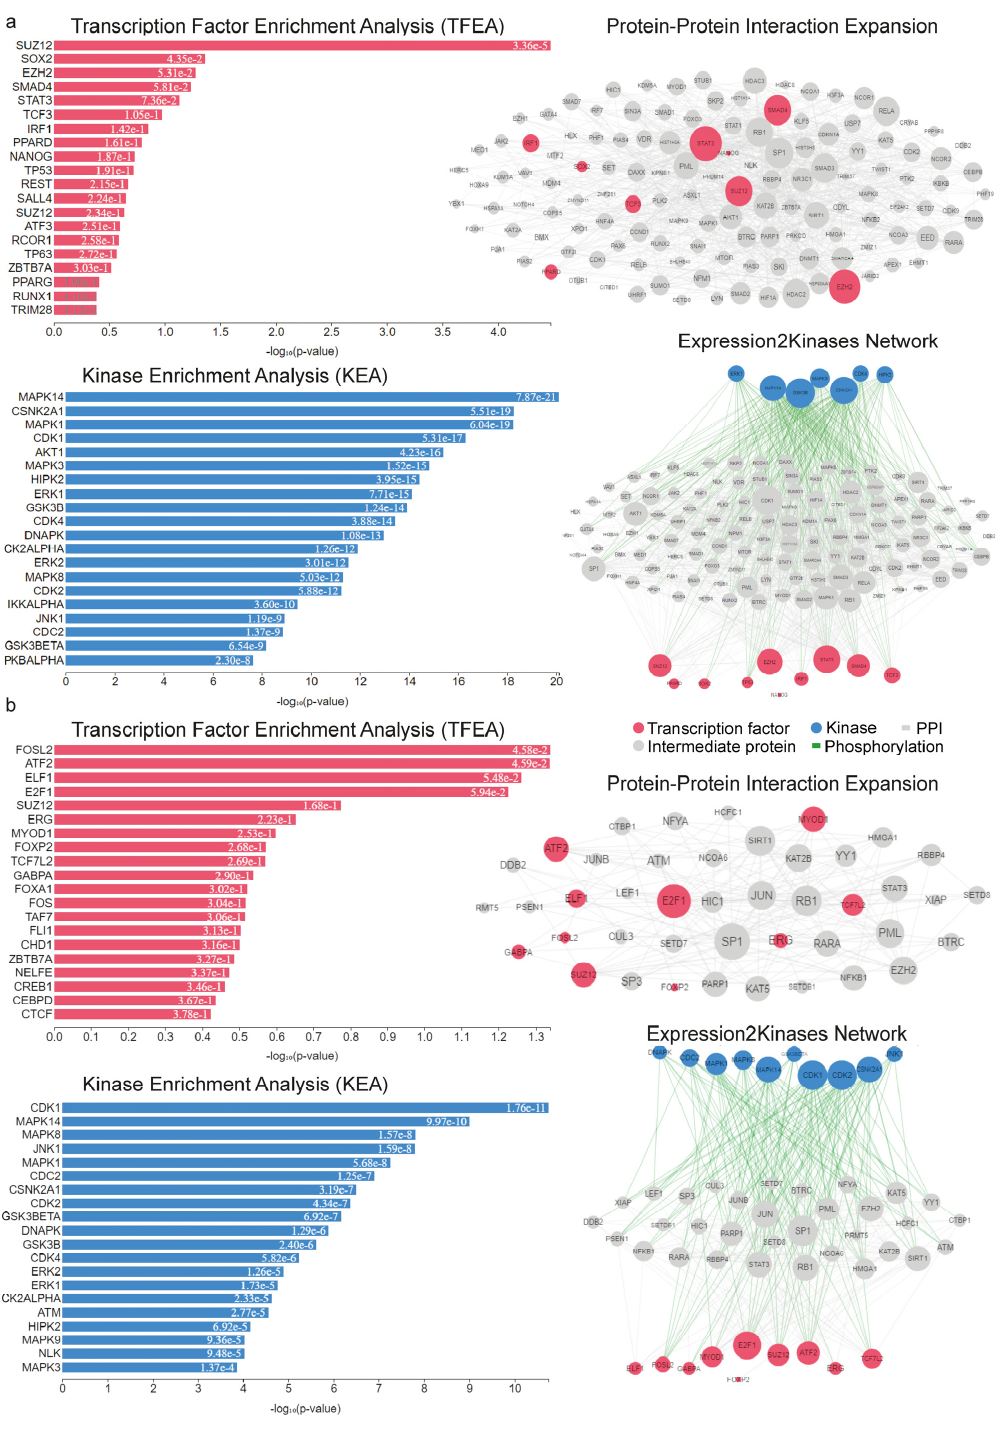
Figure 5. Networks of upstream regulators for most up- ( a ) or downregulated ( b ) genes in adult RUNX1/RUNX1T1 AML patients (GSE37642 dataset).